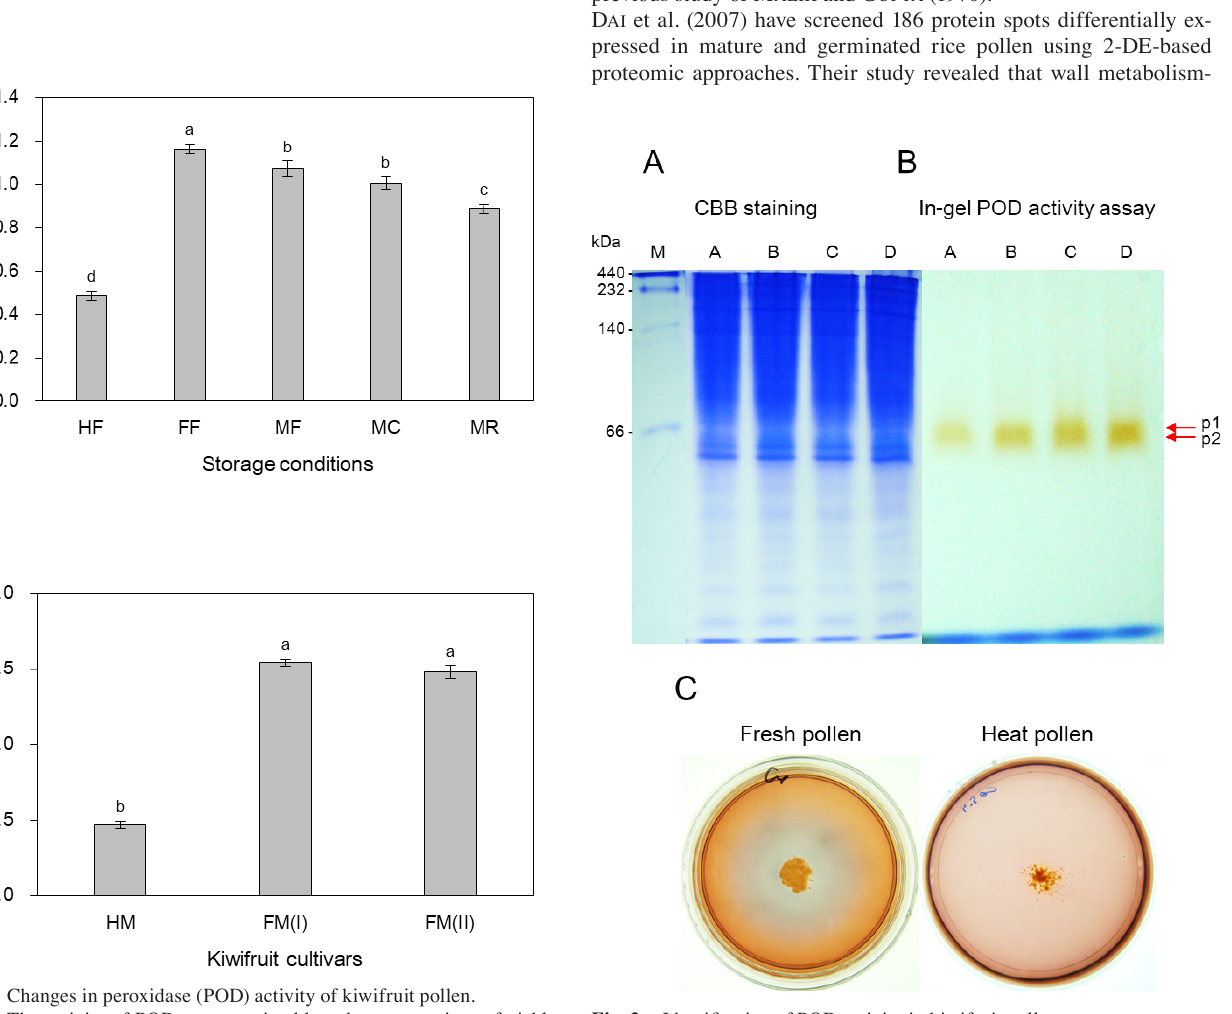
Fig. 3: Identification of POD activity in kiwifruit pollen. Proteins were loaded to 10% (w/v) gel and resolved by native PAGE. After electrophoresis, protein bands were visualized by CBB stain- ing (A), and POD activities were detected by in-gel activity assay (B). POD activity was also confirmed by decoloration of germina- tion medium supplemented with 0.01% (w/v) Congo Red (C). M, size marker; A, heat-treated Matua I; B, moisture-treated Matua I; C, fresh Matua I; D, fresh Matua II. Arrows indicate two POD iso-